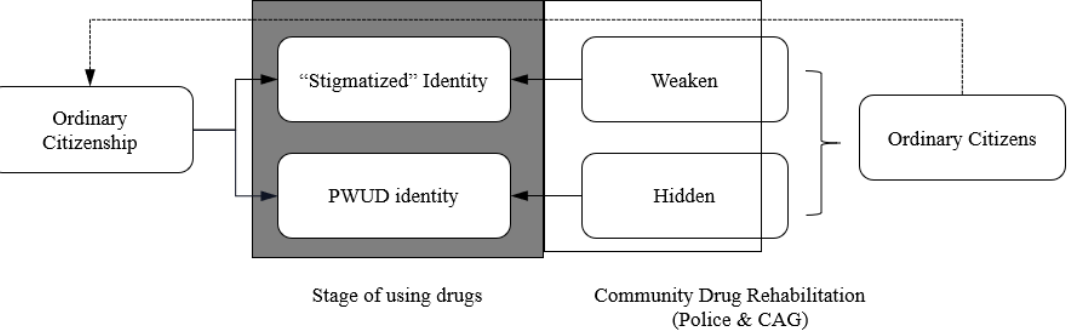
Figure 3. Processes of disengagement model among urban PWUD in China (compare to Dingle).